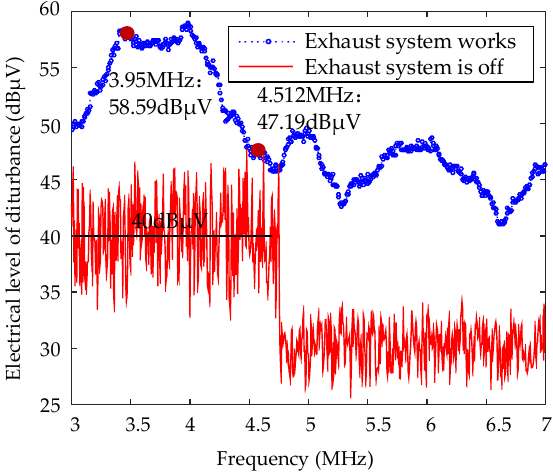
Figure 18. The disturbance level for exhaust system.